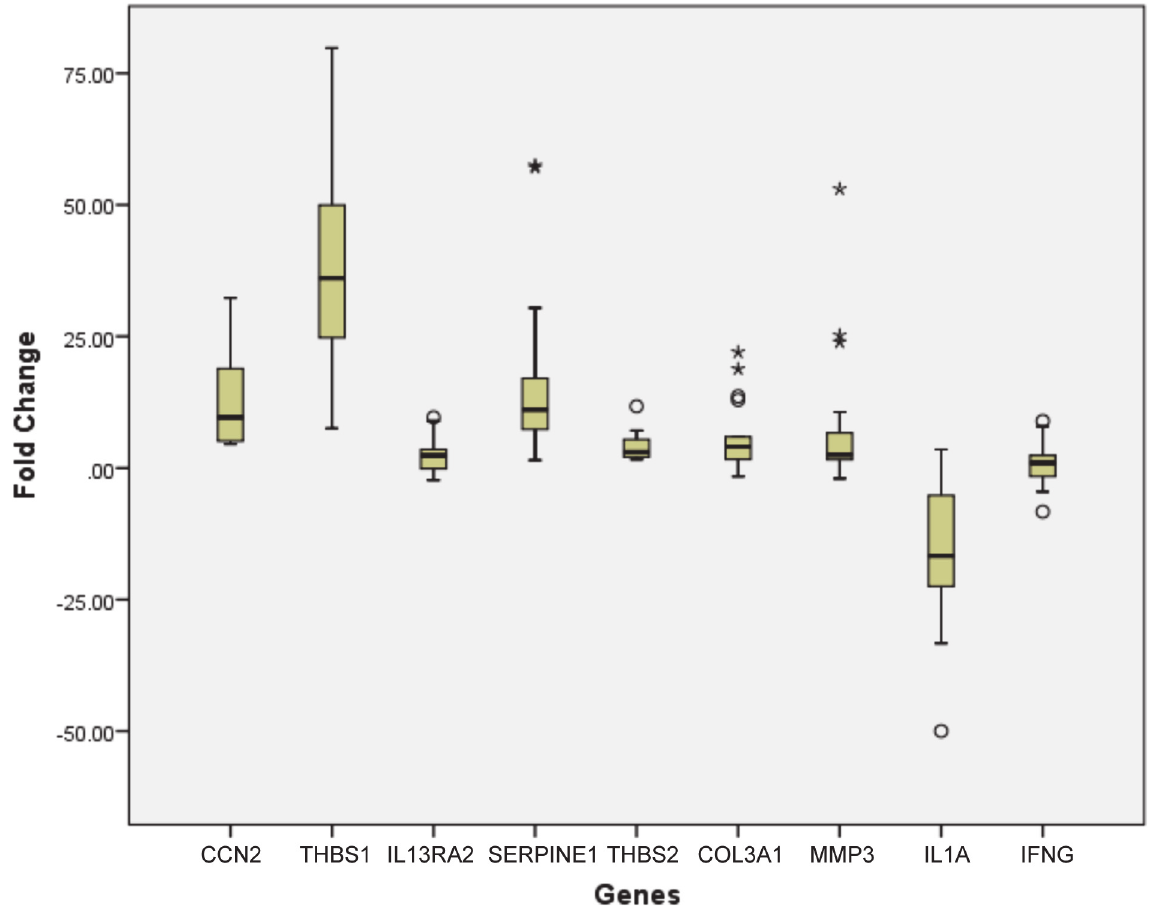
Fig 3. Validation of differential gene expression by TaqMan Gene expression assays. The differential gene expression was statistically significant (p value from < 0.001 to 0.022) by non-parametric Mann-Whitney U test except for IFNG and IL13RA2.